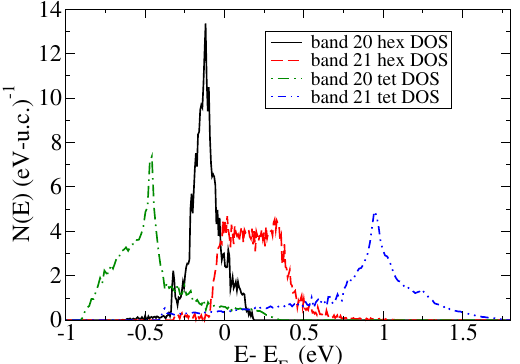
Figure 5. The calculated densities-of-states for the individual bands of non-magnetic FeS, as indicated. Note that for the tetragonal phase there are two more bands crossing E F , but we omit these in the interest of clarity. For each polymorph the zero of energy is taken as the respective Fermi energy.